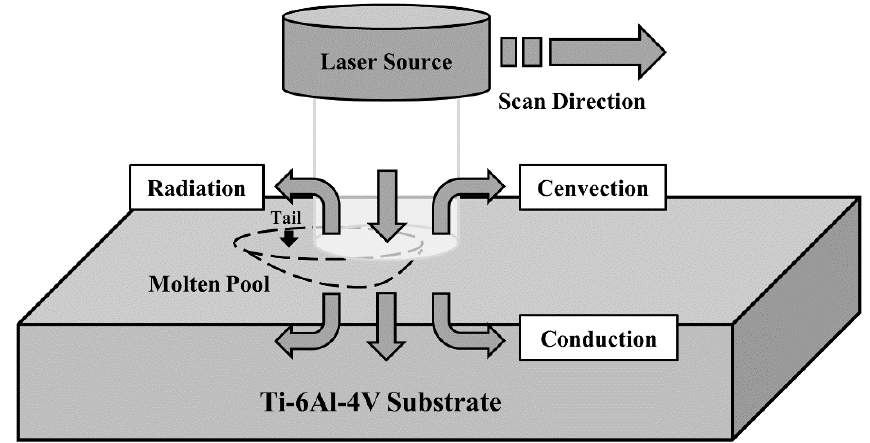
Figure 1. Heat transfer diagram.